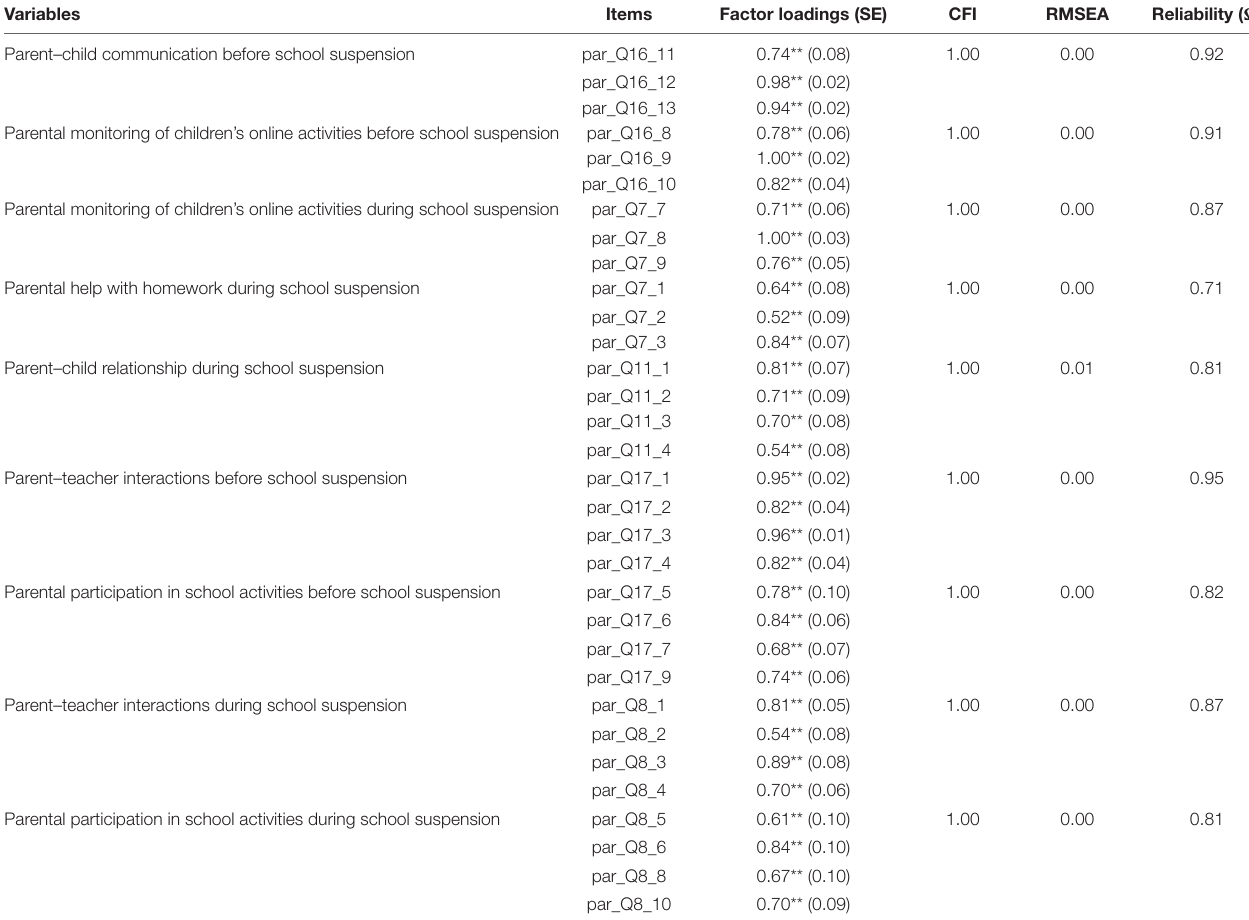
TABLE 1 | CFA for parenting variables (primary schools). Variables